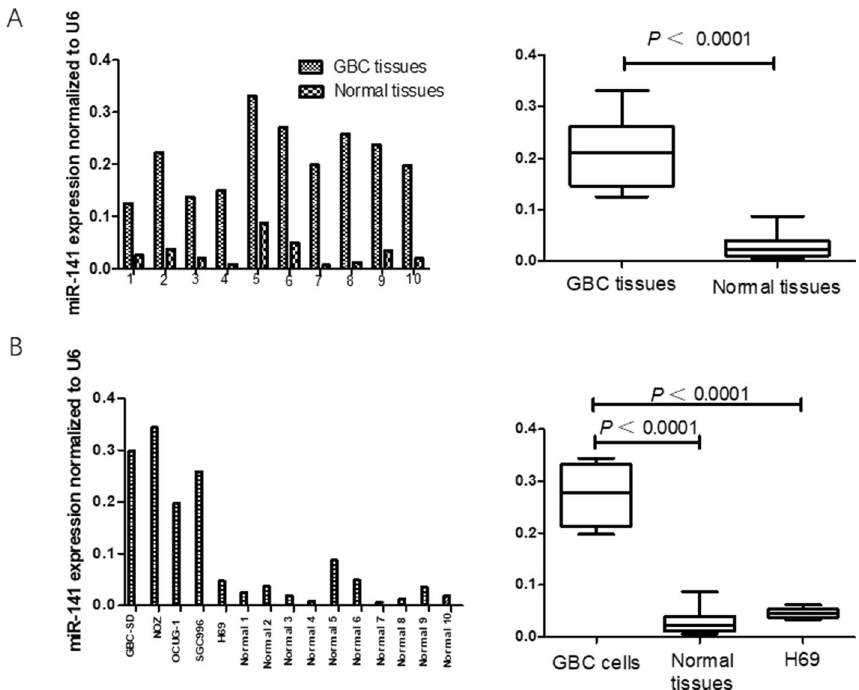
Figure 1. The expression levels of miR-141 in gallbladder cancer (GBC) tissues and GBC cell lines. ( A ) The expression levels of miR-141 were significantly higher in GBC tissues than in paired adjacent normal gallbladder tissues ( P < 0.0001; Wilcoxon t-test). ( B ) The expression levels of miR-141 were significantly higher in GBC cell lines than in the human normal biliary epithelial cell line (H69) and normal tissues ( P < 0.0001; Mann–Whitney U-test). RNU6B (U6) was used as an internal control.